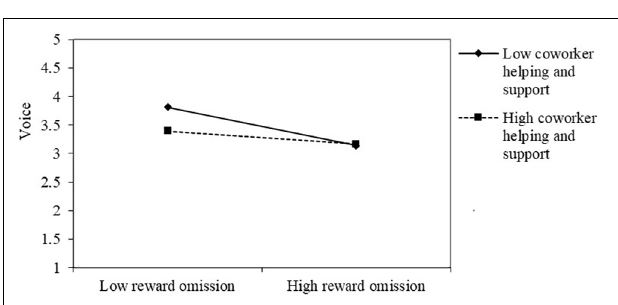
FIGURE 3 | The moderating role of coworker helping and support in the relationship between reward omission and